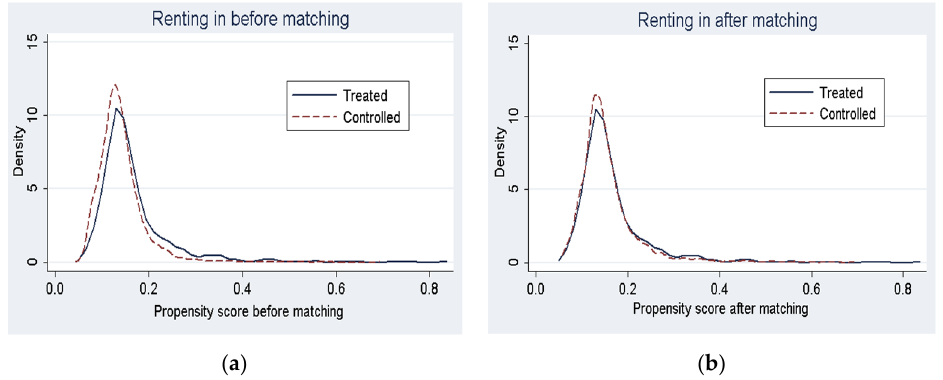
Figure 1. Common support assumption test for renting-in land density distribution of p -scores before and after matching. ( a ) Renting in before matching; ( b ) Renting in after matching.